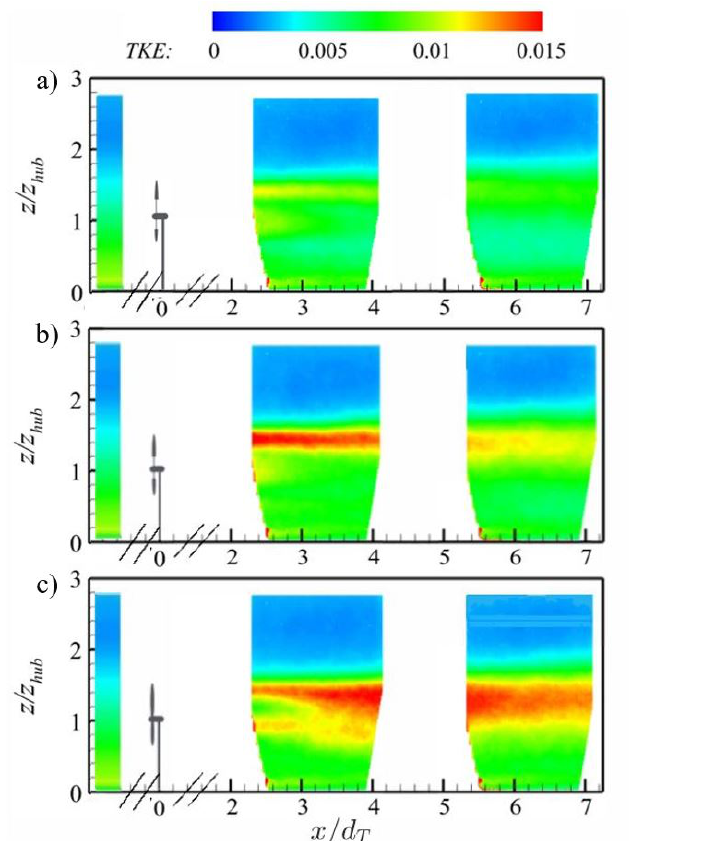
Figure 7. Turbulence kinetic energy, TKE = (cid:104) u (cid:48) 2 + w (cid:48) 2 (cid:105) /2 U 2 0.6; ( b ) L / R = 0.7; ( c ) L / R = 1.